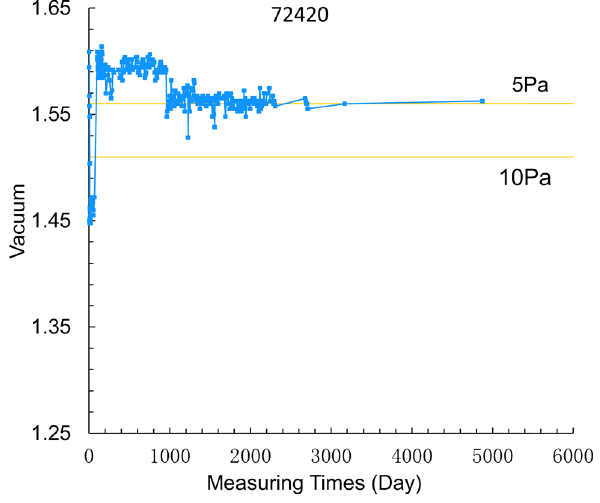
Figure A5: Relationship between vacuum holding voltage and time in No. 72420 vacuum packaging